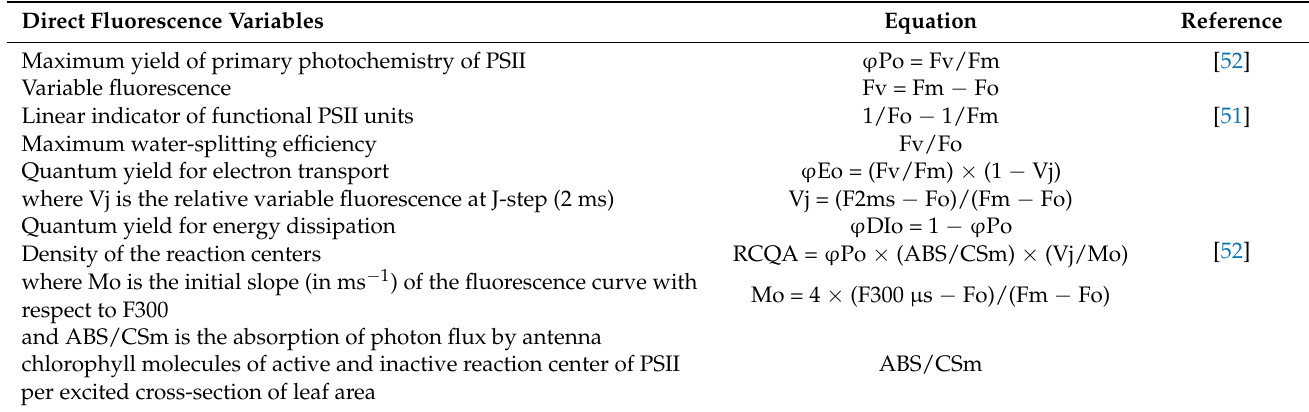
Table 1. Direct chlorophyll fluorescence of PSII main and derived